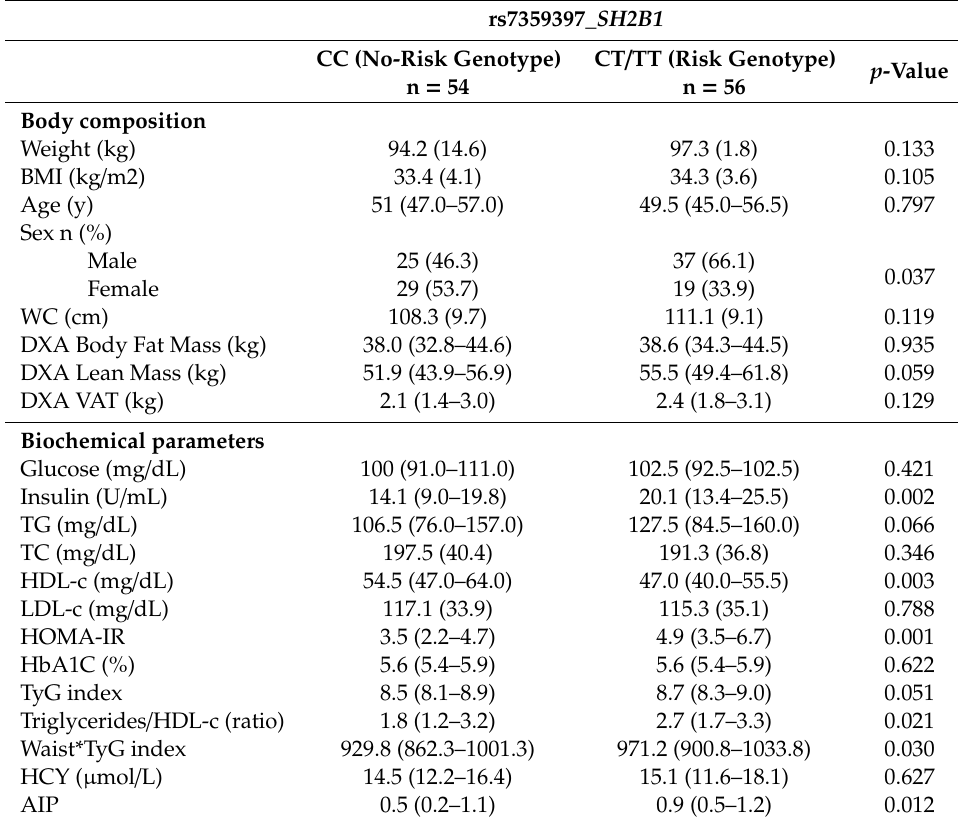
Table 1. Body composition and general biochemical parameters of participants according to genotype (risk and non-risk